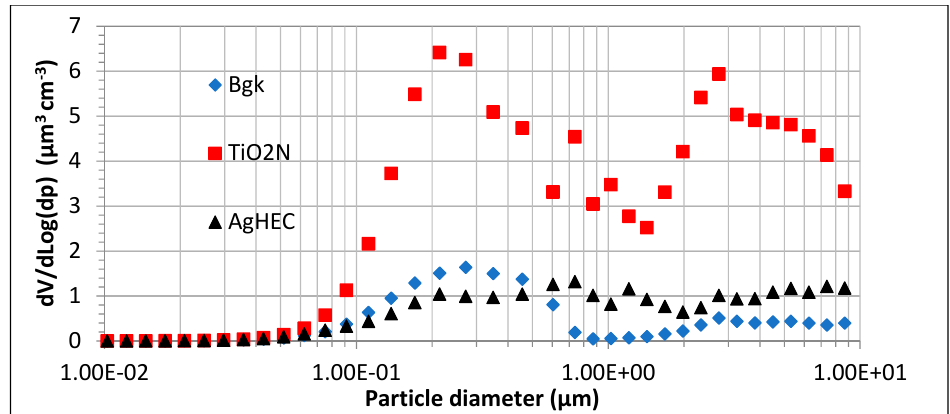
Figure 3. Averaged volume particle size distributions for background (Bgk), TiO 2 N and AgHEC at field campaigns.